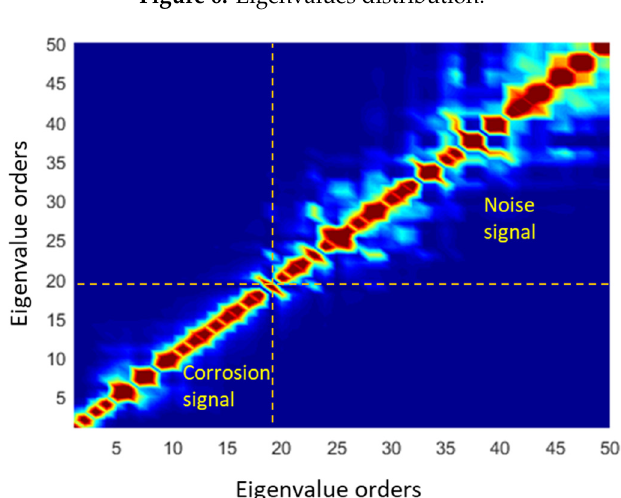
Figure 7. W–correlation that could separate noise signal and corrosion signal.